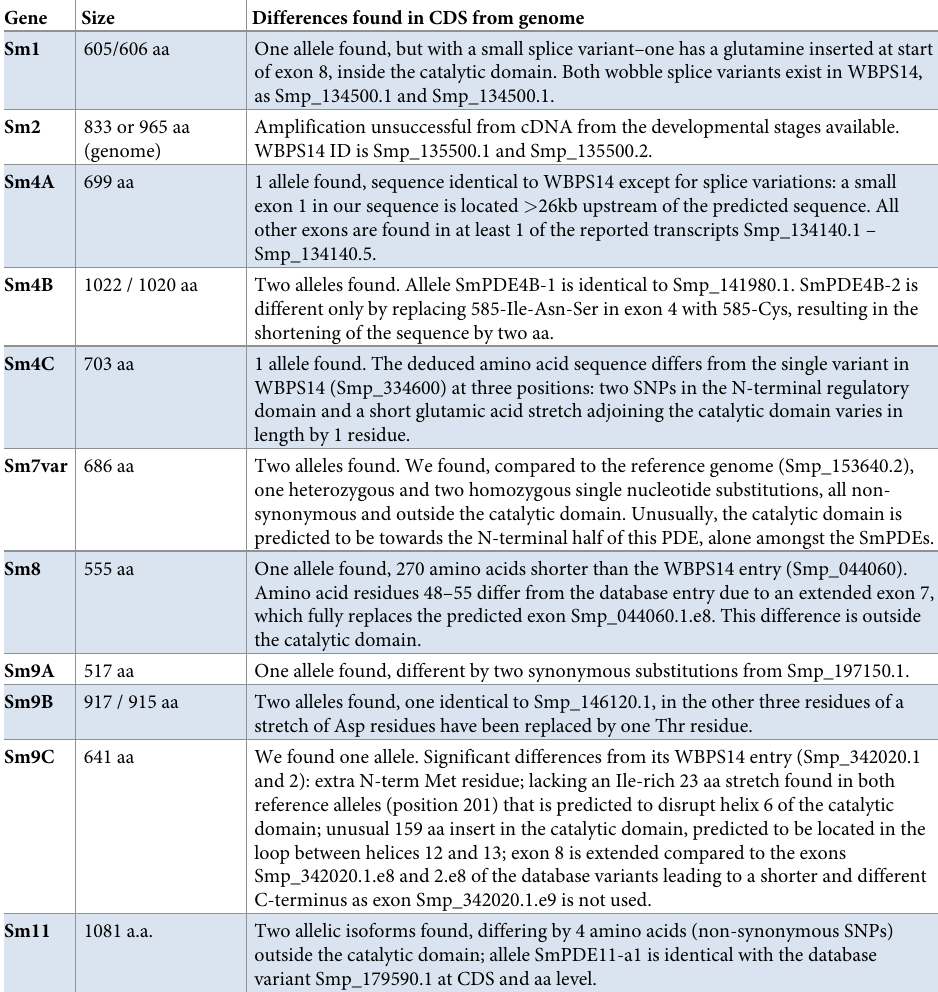
Table 2. Coding sequences differences between predicted genome sequence from WormBase ParaSite 14 and sequence obtained from cDNA from Cairo strain CD of S . mansoni . Gene Size Differences found in CDS from